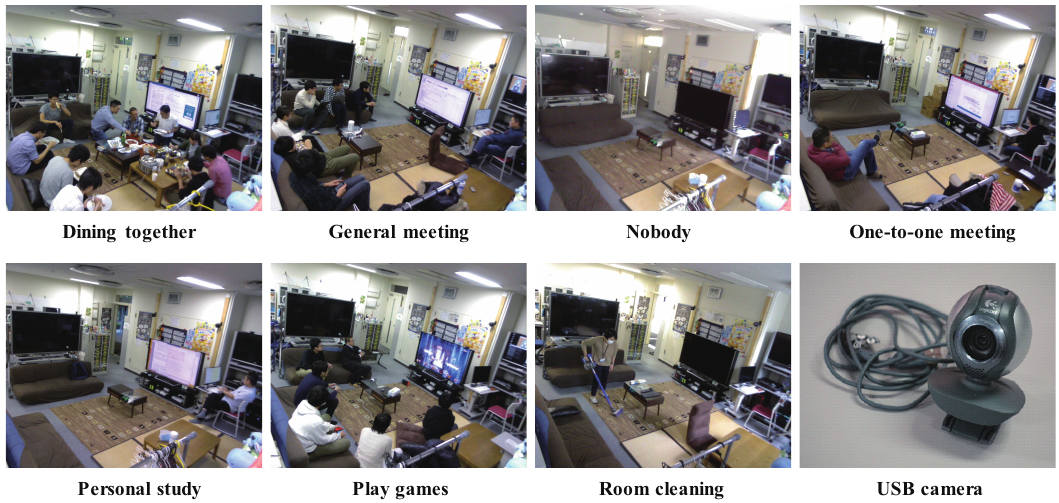
Figure 3. The representative images of each context and USB camera in this